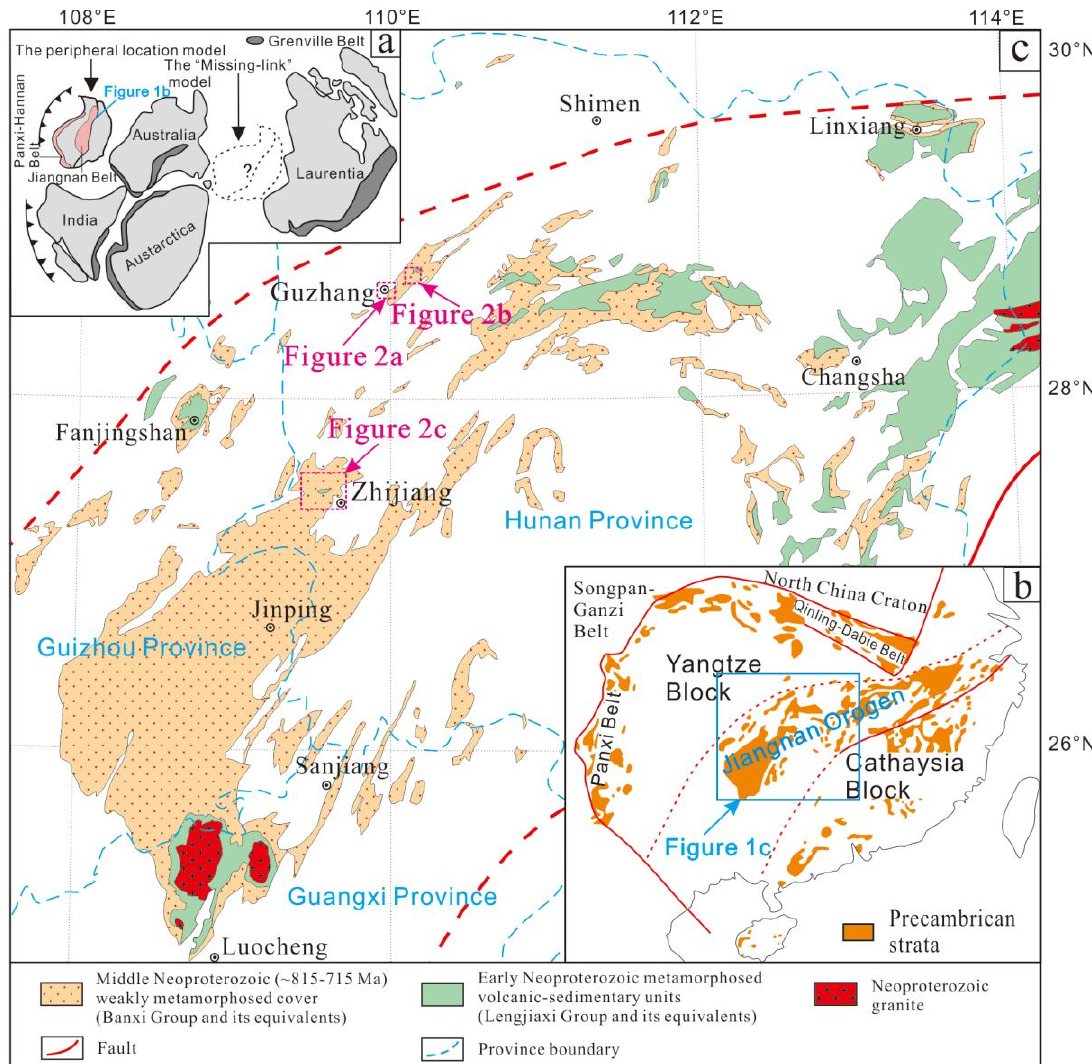
Figure 1. ( a ) Position of the South China Block in the reconstruction of Rodinia (modified after [44]). ( b ) Geological map showing the distribution of Precambrian strata of South China. The Jiangnan Orogen separated the Yangtze Block in the northwest from the Cathaysia Block in the southeast (modified after [42,45]). ( c ) Simplified geological map of the Western Jiangnan Orogen (WJO) (revised after [46–48]).